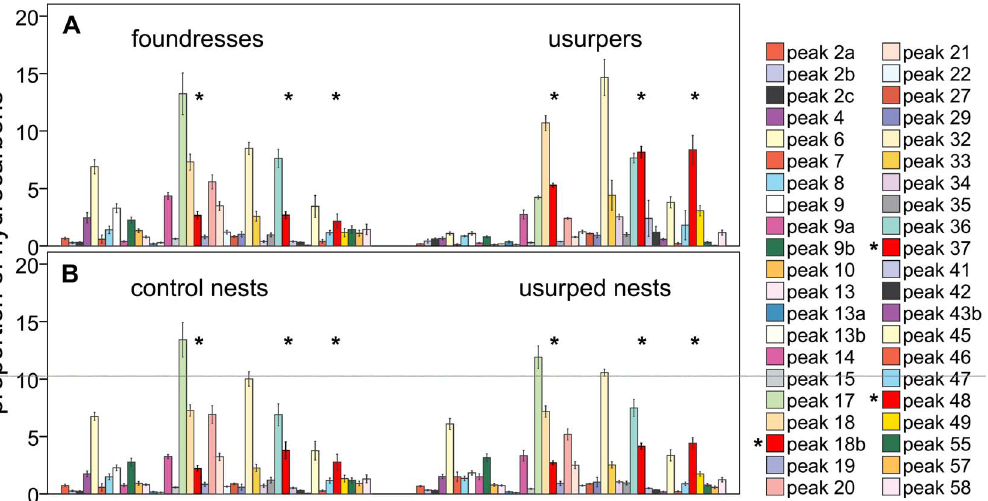
Figure 3. The proportions of branched alkanes and linear alkenes in A) foundresses, B) usurpers, C) control nests and D) usurped nests. Bars are mean ( 6 E.S.) of proportions. The asterisks indicate the three peaks whose increases in usurped nests might have strong consequences on worker discrimination abilities (see text).